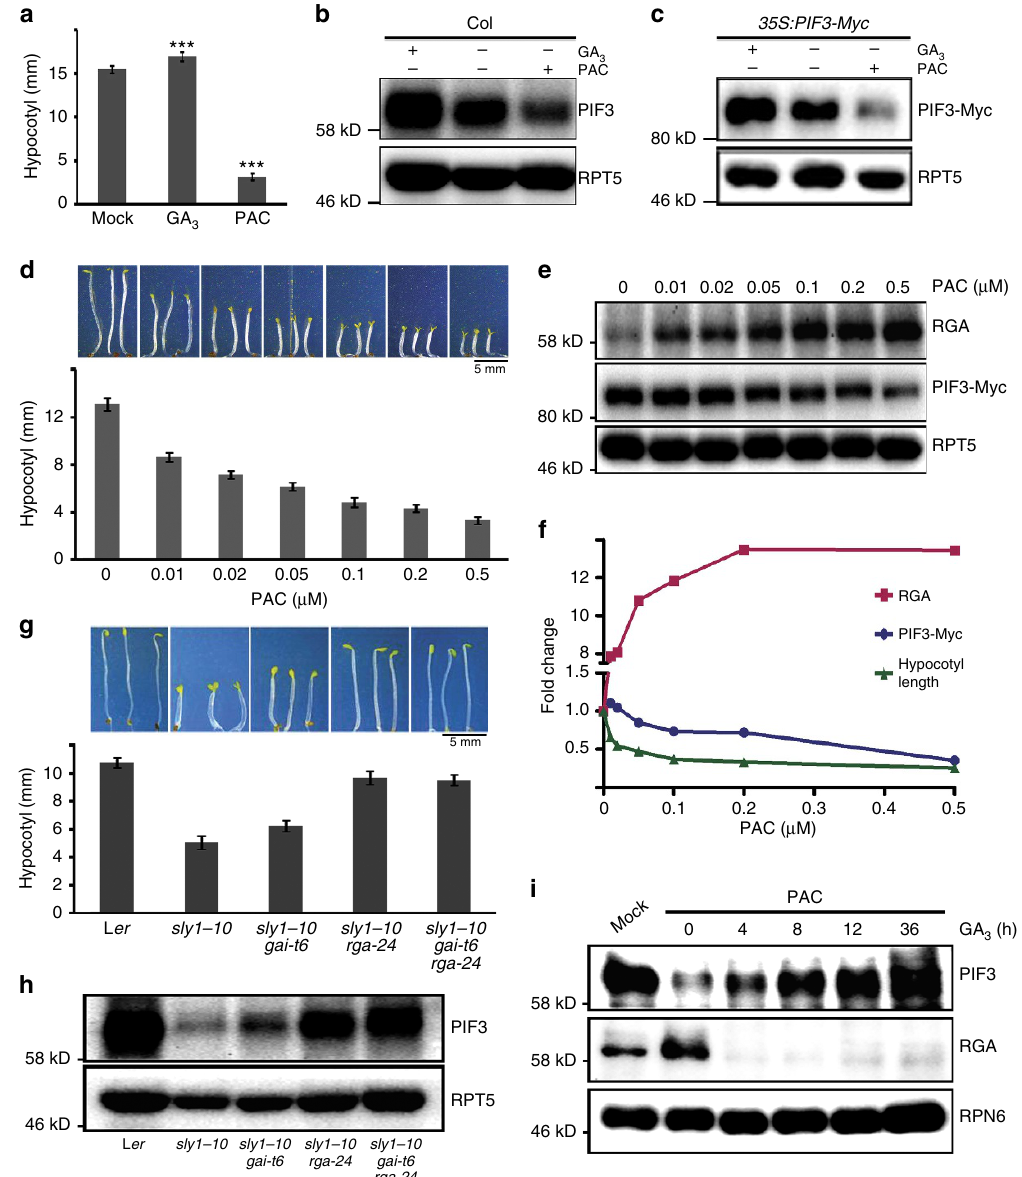
Figure 3 | Regulation of PIF3 protein abundance by DELLAs correlates with GA-regulated hypocotyl elongation. ( a ) Hypocotyl lengths of 4-day-old dark-grown wild-type (Col) seedlings treated with GA 3 (10 m M) or PAC (0.5 m M). Statistical significance was determined using the Student’s t tests between the GA 3 or PAC treatment and Mock. *** P o 0.001. ( b , c ) Effects of GA 3 or PAC treatment on PIF3 and PIF3-Myc protein abundance. The seedlings were grown in the medium with indicated supplements, and total proteins were analyzed by immunoblots using anti-PIF3, anti-Myc and anti-RPT5. ( d ) Phenotypes and hypocotyl lengths of 4-day-old dark-grown 35S:PIF3-Myc seedlings treated with different concentrations (0, 0.01, 0.02, 0.05, 0.1, 0.2 and 0.5 m M) of PAC. All images were under the same magnification. ( e ) RGA and PIF3-Myc protein levels of the seedlings as shown in ( d ). ( f ) Relative changes of RGA, PIF3-Myc, and hypocotyl lengths of the seedlings shown in ( d , e ). The values of starting points were set to 1. ( g ) Phenotypes and hypocotyl lengths of 4-day-old dark-grown seedlings. All images were taken under the same magnification. ( h ) Endogenous PIF3 protein levels of the seedlings shown in ( g ). ( i ) PIF3 protein levels in Col seedlings treated with PAC and GA. Seedlings were grown on 0.2 m M PAC-containing medium in darkness for 4 days and then treated with 100 m M GA 3 for indicated times. Each immunoblot result is the representative of at least three repeats, and RPN6 was used as a loading control. In ( a ), ( d ) and ( g ), Means ± s.d. were obtained from at least 20